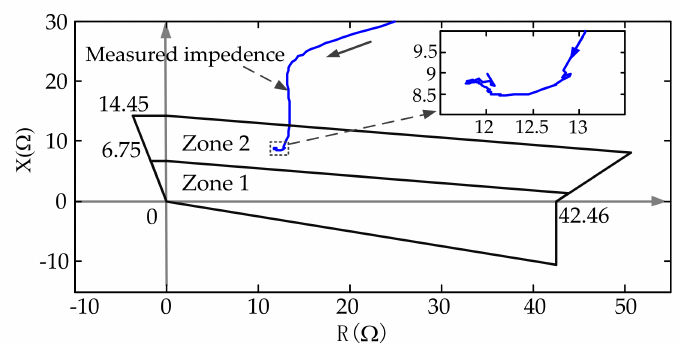
Figure 7. The phase B impedance trajectory of the wind farm side when a phase B ground fault occurs on the transmission line connected to a DFIG-based wind